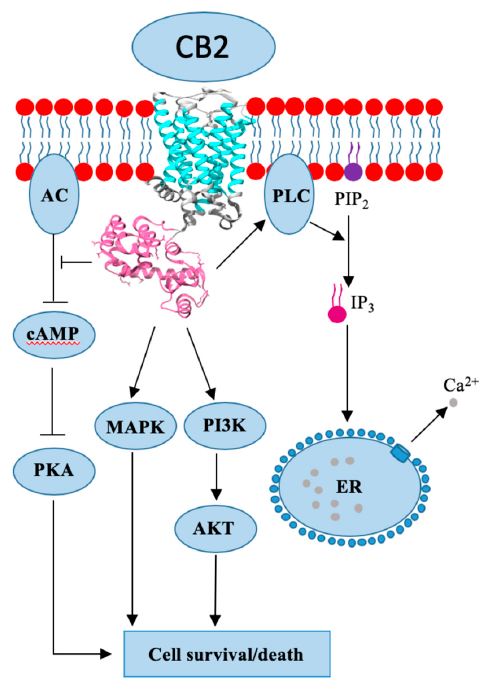
Figure 2. Cannabinoid receptor 2 (CB2) crystal structure and mode of action.